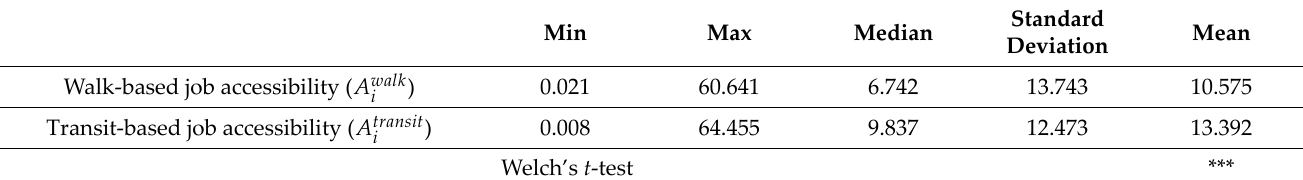
Table 2. Descriptive statistics of walk‑based and transit‑based job accessibility measured at the neigh‑ borhood